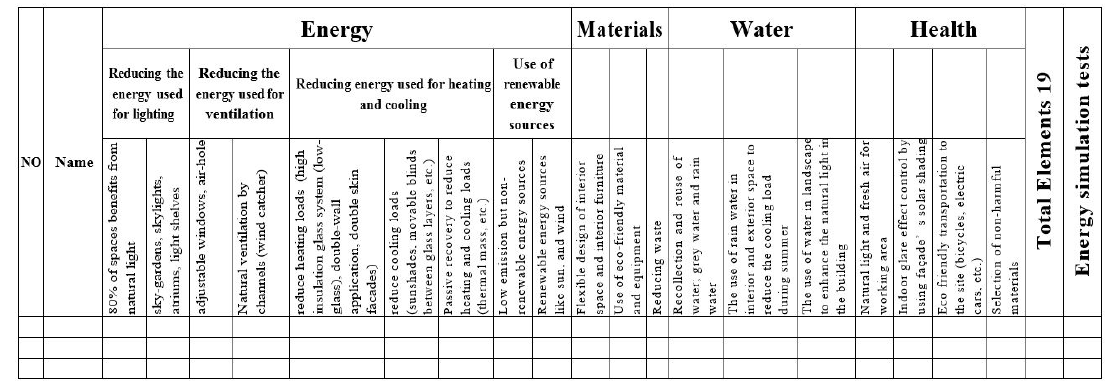
Figure 5. Sustainable principles checklist